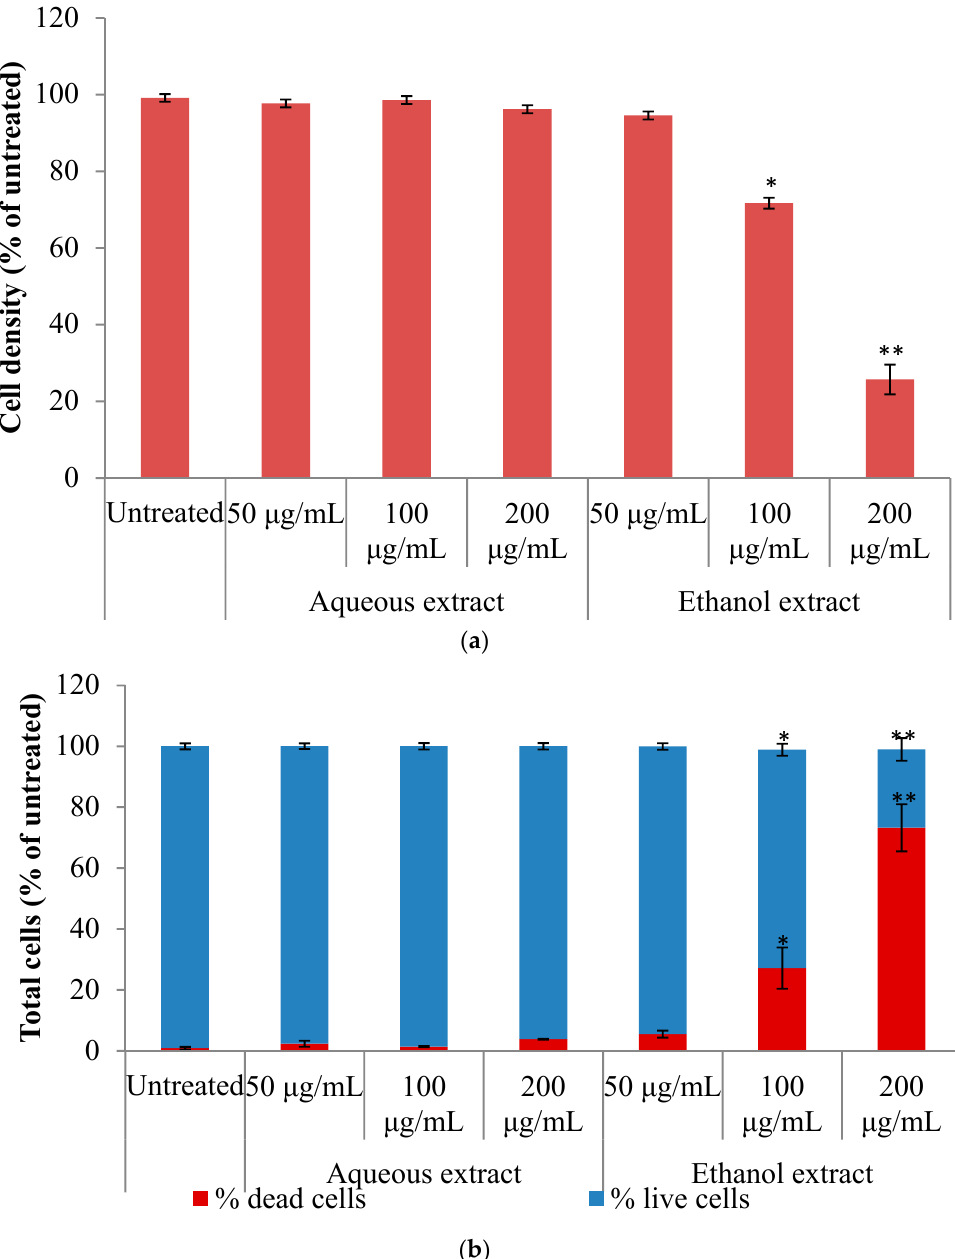
Figure 5. ( a ) The number of live HeLa cells present after 48 h of exposure to aqueous and ethanolic extracts of Vernonia mespilifolia . Nuclei were stained with Hoechst 33,342 and PI (propidium iodide), and images were acquired on the ImageXpress Extended Light Scatterer (XLS) Micro widefield microscope. The total number of nuclei (cells) were counted using the Multiwavelength Cell Scoring module. Data points represent mean ± SD of five quintuplicate values (* p < 0.05; ** p < 0.01 compared to untreated sample). ( b ) The total number of HeLa cells (live + dead) present after 48 h of exposure to aqueous and ethanolic extracts of Vernonia mespilifolia . Nuclei were stained with Hoechst 33,342, and images were acquired on the ImageXpress XLS Micro widefield microscope. The total number of nuclei (stained with Hoechst) and the number of dead nuclei (stained with Hoechst and PI) were counted using the Multiwavelength Cell Scoring module. Live cells were stained with Hoechst only, while dead cells were stained with both dyes. Data points represent mean ± SD of five quintuplicate values (* p < 0.05; ** p < 0.01 compared to untreated sample).